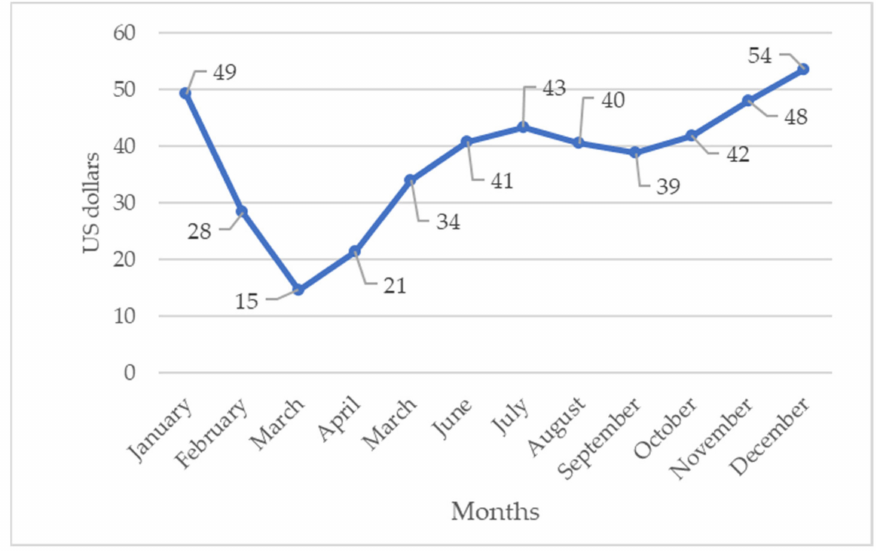
Figure 2. Dynamics of the average price per barrel of oil exported by Iraq, in 2020, US